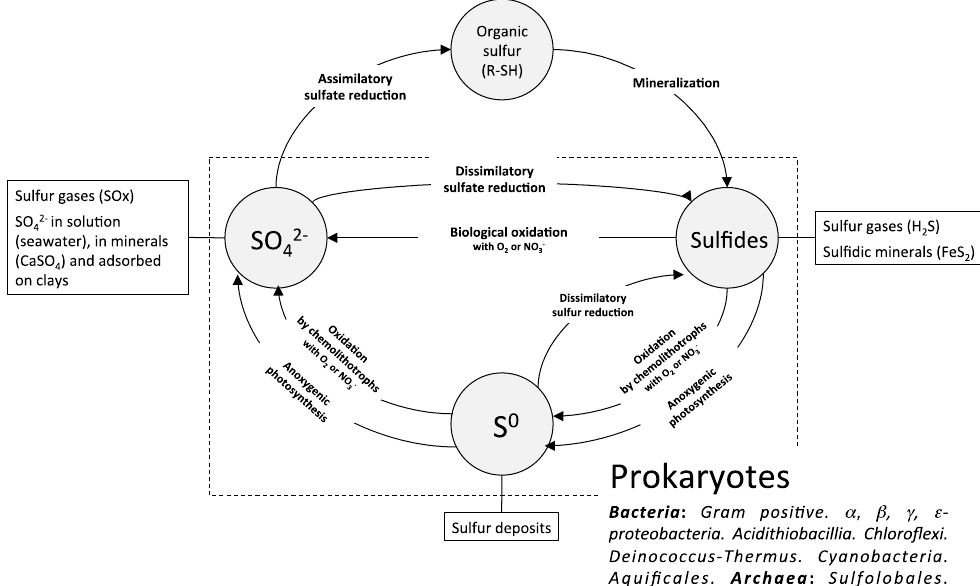
Figure 1. Sulfur reservoirs and the biological sulfur cycle. Adapted from [13].